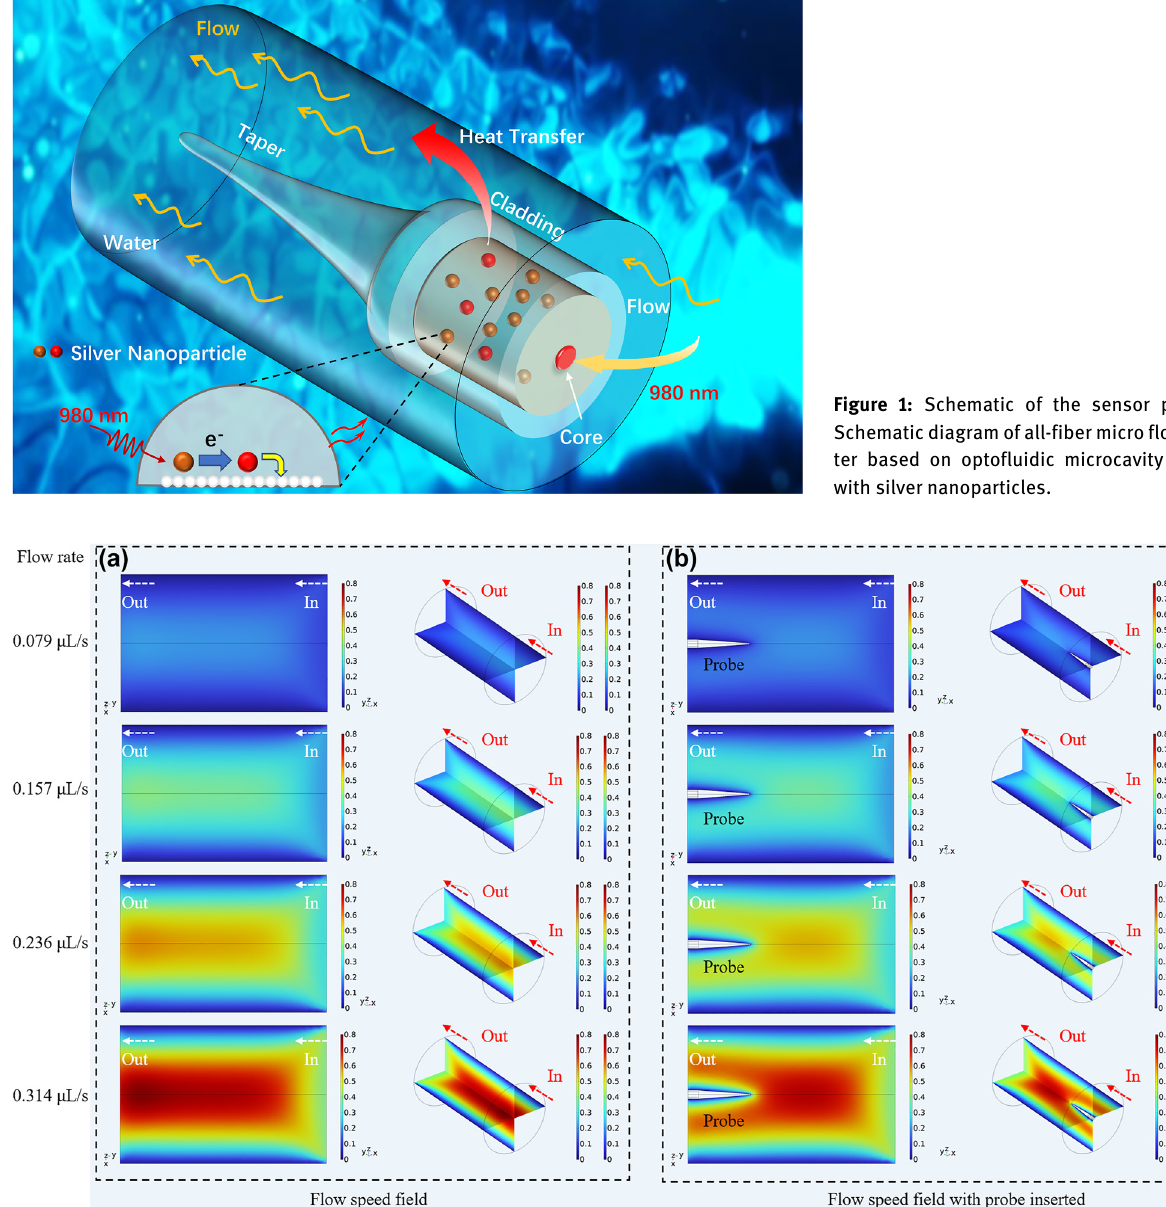
Figure 2: Distribution of speed field in channel under different flow speed: (a) without probe inserted, (b) with probe inserted. Besides, the effect of insertions of the probe on the actual flow velocity field in channels of various sizes is investigated. The flow velocity field of the radial flow field